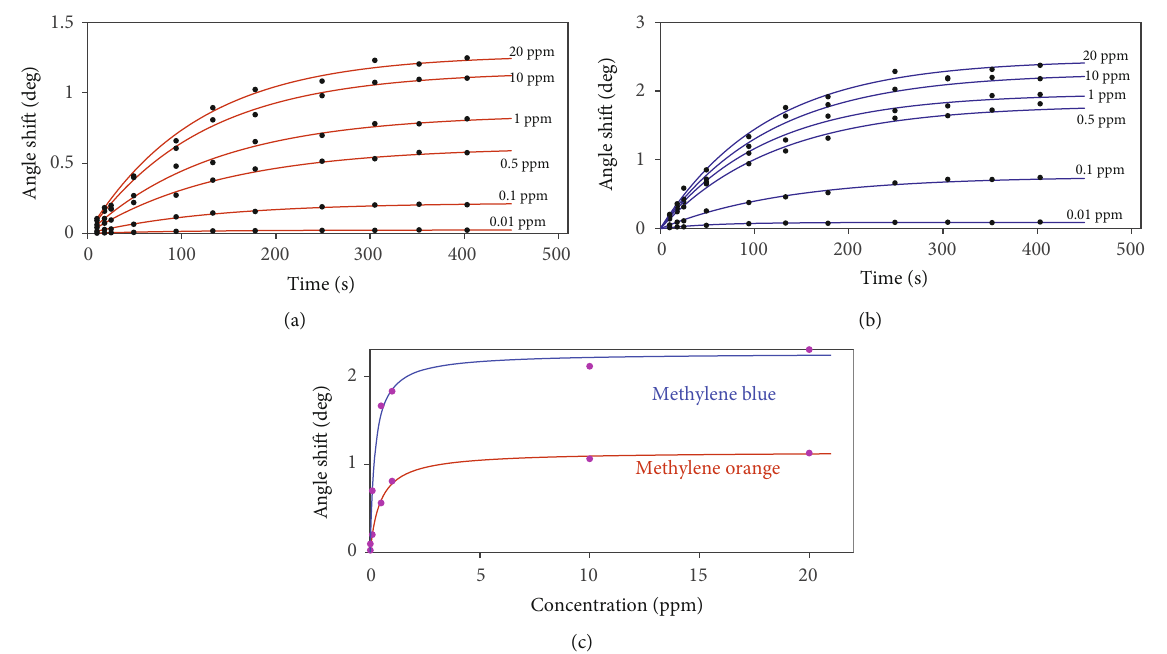
Figure 4: Variation of the resonance angle shift with time for (a) MO and (b) MB. (c) Variation of the resonance angle shift with di ff erent concentrations of MO and MB. The solid lines in parts (a) and (b) fi t fi rst-order Langmuir theory well.